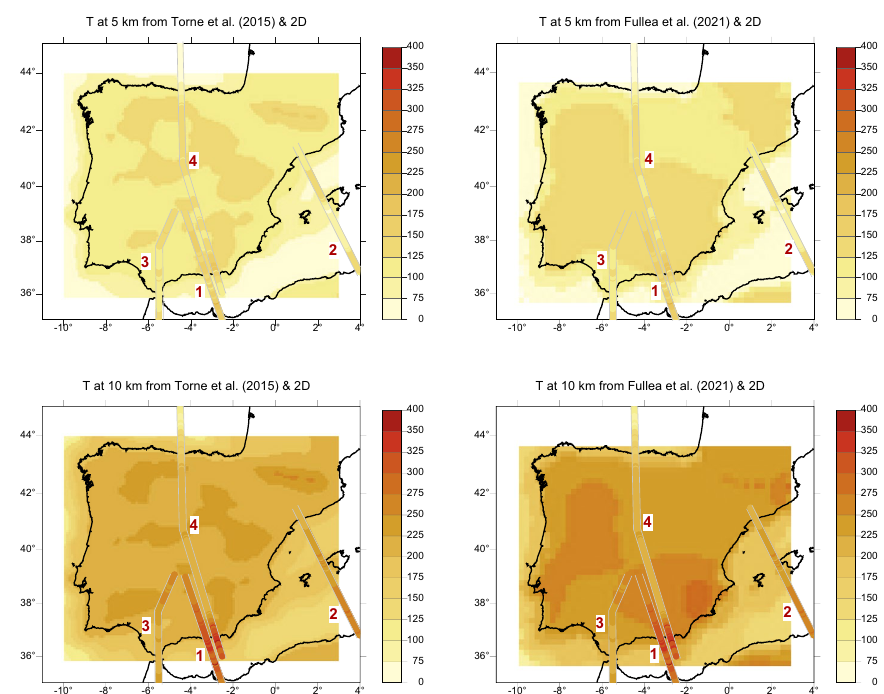
Fig. 6 Temperature distribution at 5 and 10 km crustal depths based on the models of Torne et al. (2015) and Fullea et al. (2021) as well as from the 2D profiles of Kumar et al. (2021) (1 and 2), Jiménez‑Munt et al. (2019) (3), Carballo et al. (2015a)